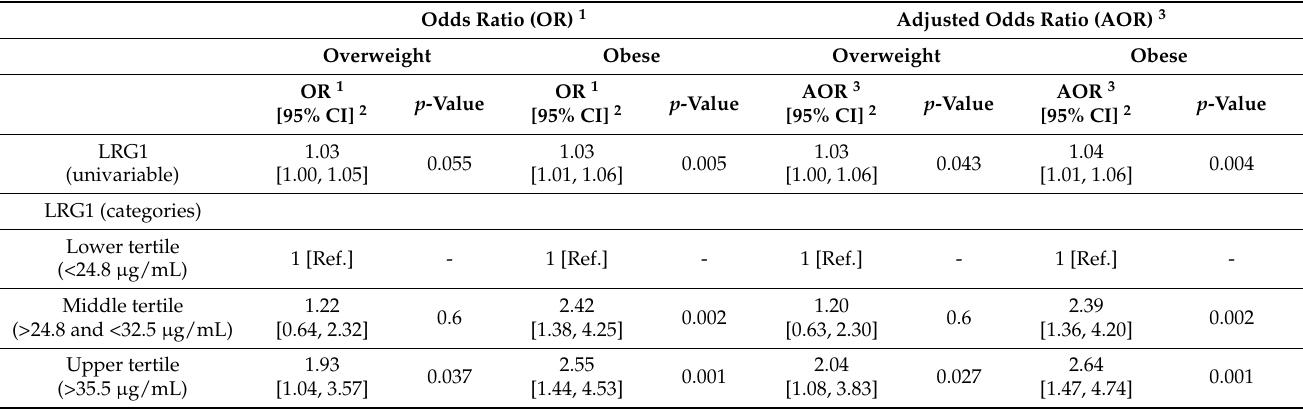
Table 2. Association between overweight/obesity and LRG1 levels in univariable and multivariable multinomial logistic